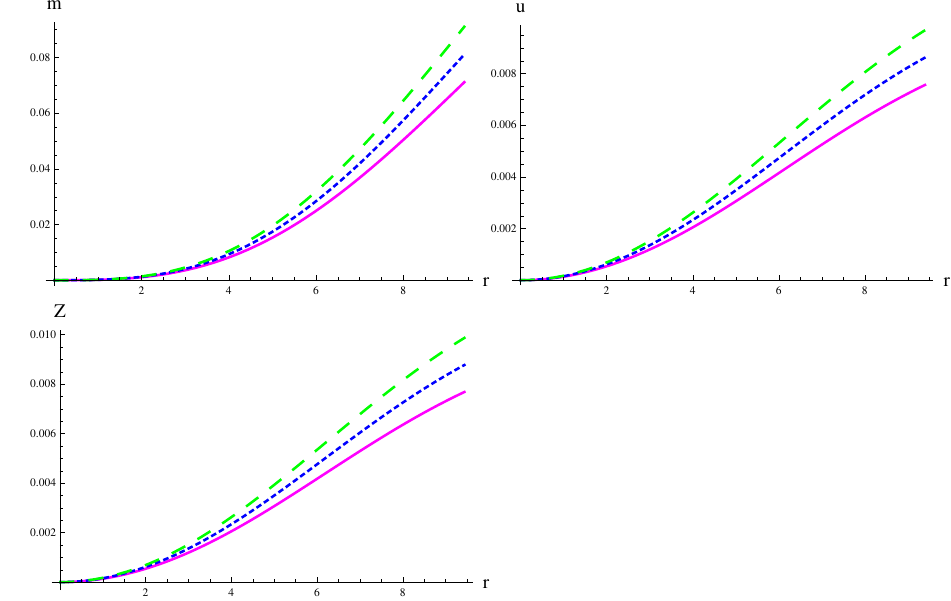
Figure 16. Behavior of m , u and Z corresponding to anisotropic solution II for Υ = 0.9. Moreover, the redshift and compactness functions stay below the required limits. Figure 17 indicates that the extended version of the isotropic solution is stable according to causality and cracking criteria for Υ = 0.2 . However, the causality condition is violated < 0 (refer to Figure 18). The plots of adiabatic index exhibit that the for Υ = 0.9 as v 2 ⊥ anisotropic distribution is less stiff near the center. However, the values of Γ become greater than the required bound after a small distance from the center for both values of Υ